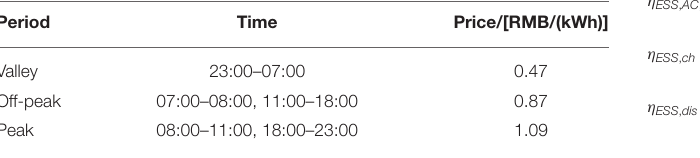
TABLE 2 | Real-time trading price.